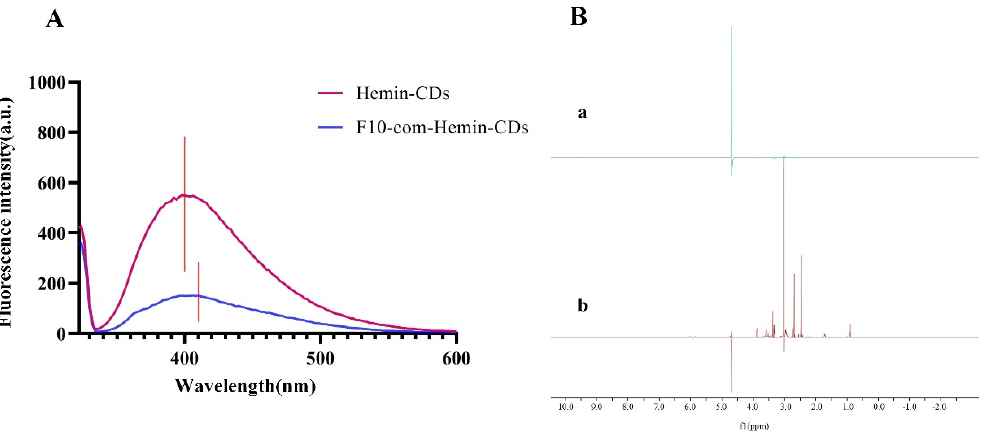
Figure 2. F10-com-hemin-CDs conjugate. ( A ) The successful coupling of F10-com and hemin-CDs was verified by the fluorescence shift method. ( B ) 1 H NMR spectra of F10-com-hemin-CDs coupling and uncoupling. a. F10-com and hemin-CDs mixture. b. F10-com-hemin-CDs conjugate.